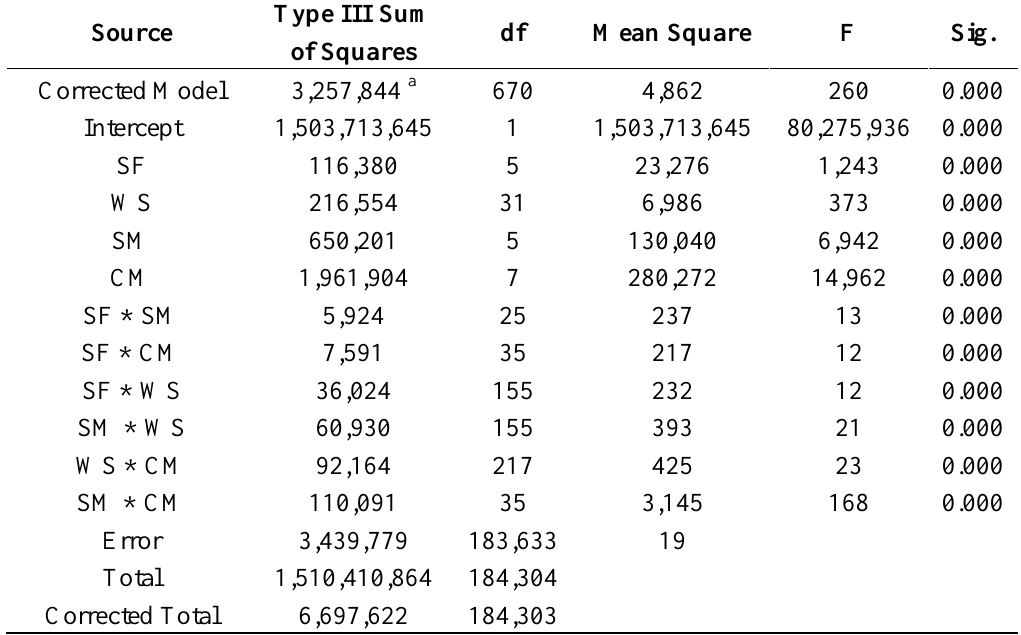
Table 2. ANOVA output for the CA as the dependent variable ( Tests of Between-Subjects Effects. Dependent Variable: CA